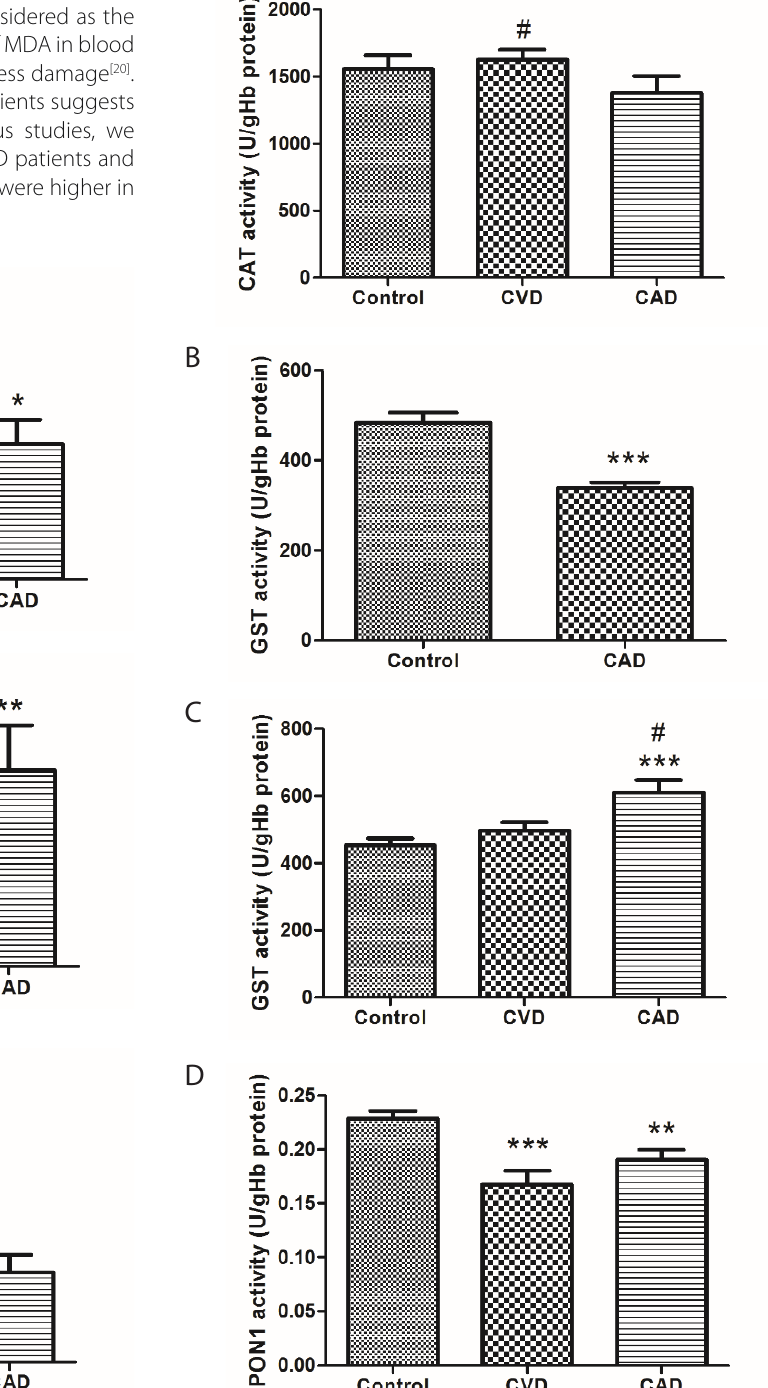
Fig. 2 - CAT (a), GST (b) and PSEN1 (c) gene expression levels in leukocyte for all groups (patients with CVD, CAD and controls). The symbols denote significant differences from the control group at (*) P<0.05 and (**) P<0.01 from the CAD group at (##)P<0.01 by using one-way ANOVA with LSD (least significant difference) post hoc